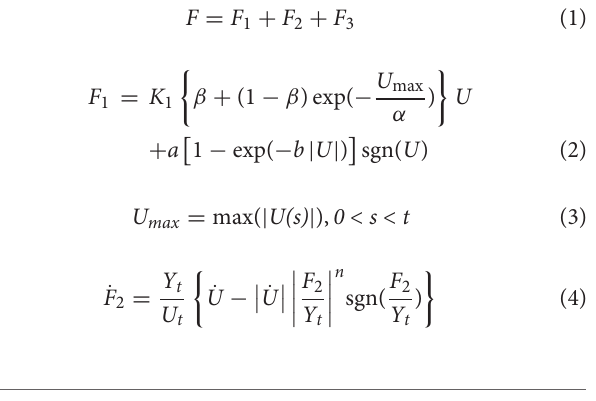
TABLE 1 | Characteristics of the tested isolator.